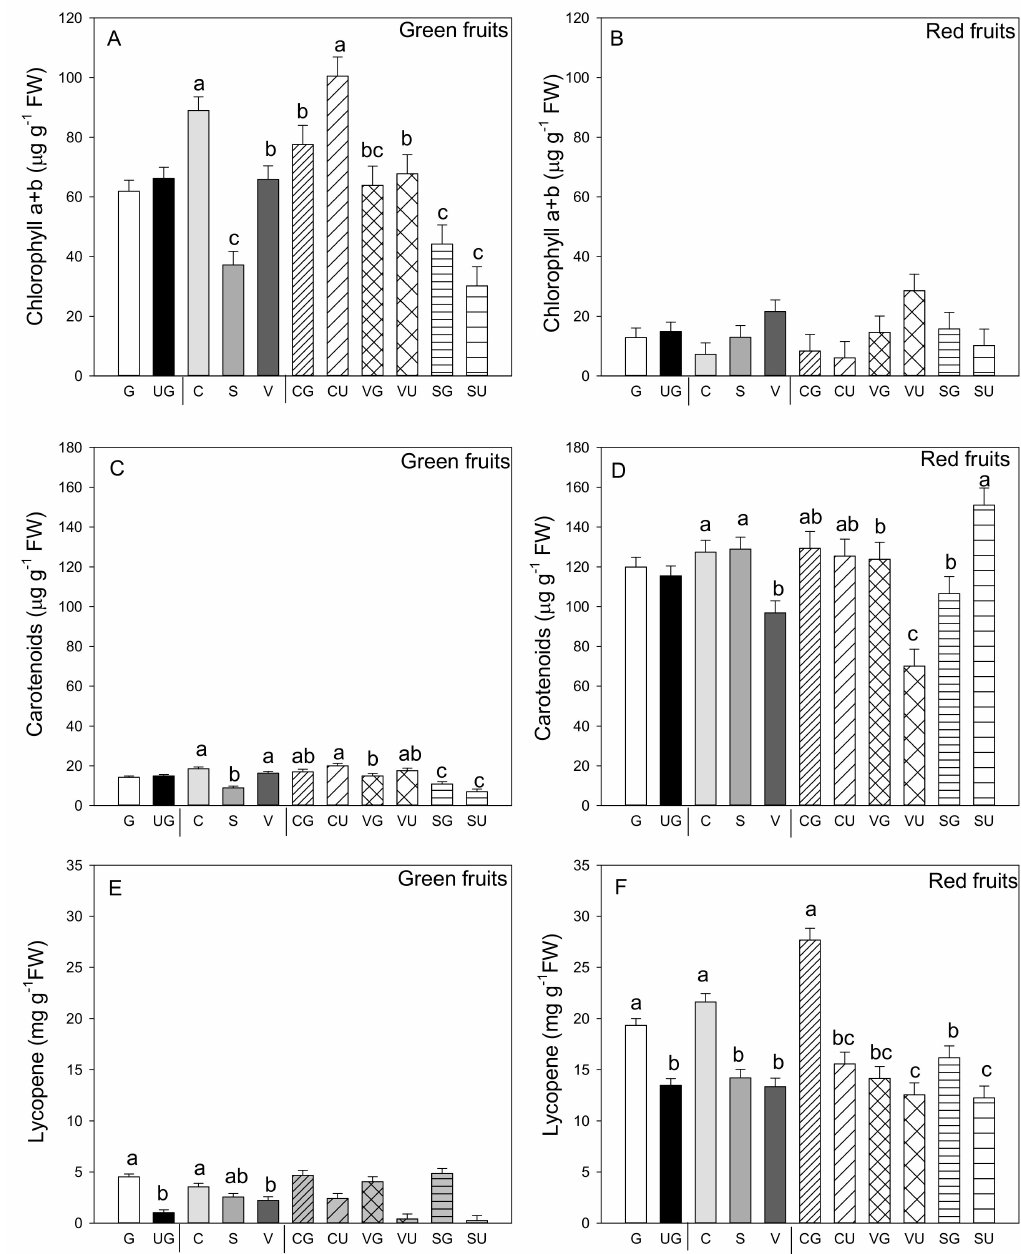
Figure 4. Chlorophyll a and b ( A , B ), carotenoid ( C , D ) and lycopene amount ( E , F ) in the green ( A , C , E ) and red ( B , D , F ) fruit produced by the three pepper landraces “Cuerno” (C), “Valencia” (V), and “Sueca” (S) grafted (G) or ungrafted (U) onto rootstock F1 NIBER ® . Values were the mean ± SE of three fruit per replicate (3 replicates) per landrace. Means were subjected to a two-way ANOVA with grafting and landrace as sources of variability. Di ff erent letters for factors grafting and landrace, or their interaction, indicate significant di ff erences at p < 0.05 using the LSD test. No letter indicates the non-significance of the F